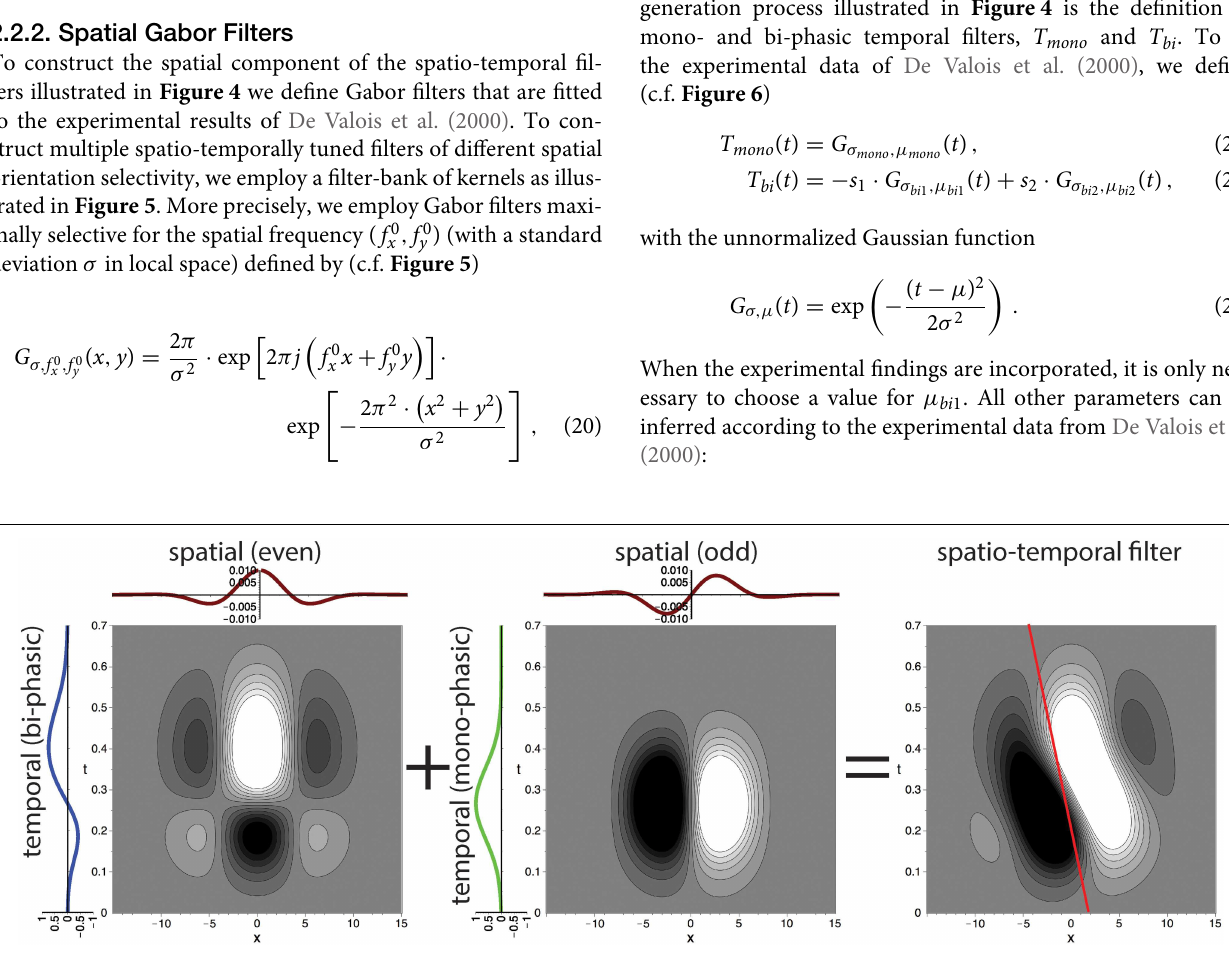
FIGURE 4 | Superposition of spatio-temporally separable filters creates motion-direction sensitive filter. The proposed spatio-temporal filter (right) is constructed by using the results of the singular value decomposition of the receptive field of motion directional cells by De Valois et al. (2000) (c.f. DeAngelis et al., 1995, their Figure 3). Two separable filters are superposed to create the final